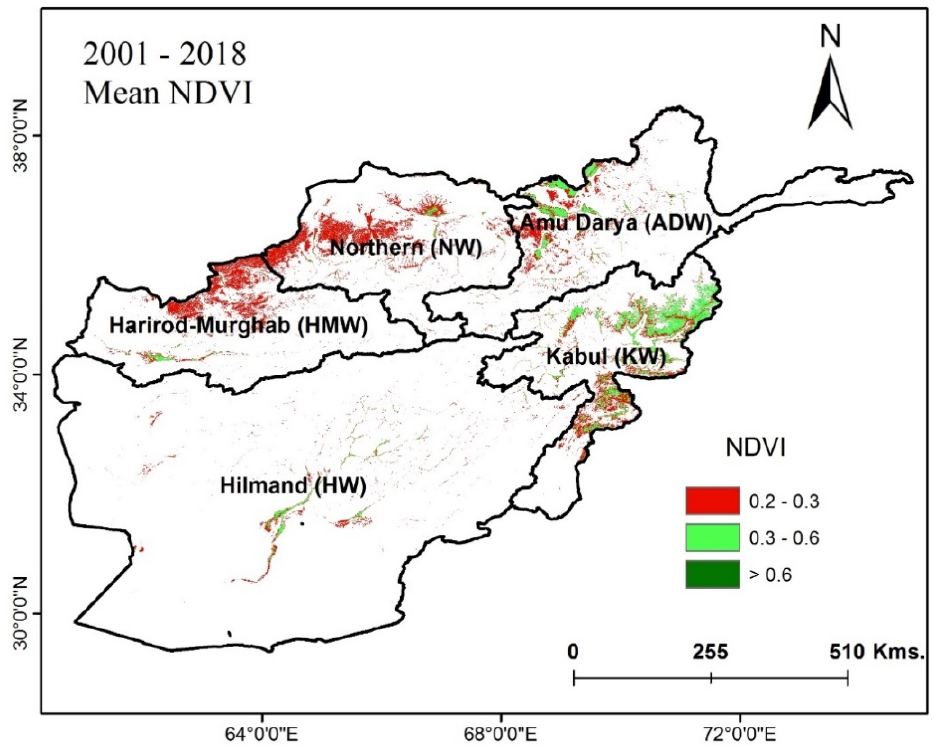
Figure 7. Area of Afghanistan with different categories of NDVI between 2001 and 2018.